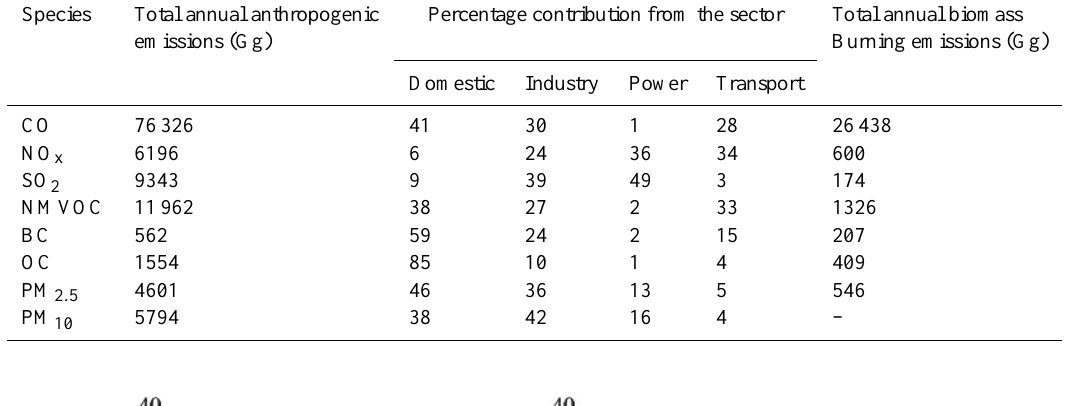
Table 1. Annual total anthropogenic CO, NO x , SO 2 , NMVOC, BC, OC, PM 2 . 5 and PM 10 emissions included in the model. The relative contributions from different source categories to the total emissions over the simulation domain are also listed.